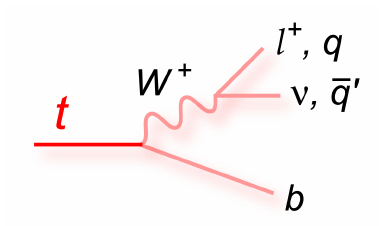
Figure 2. Candidate event for the ttH process, in which one W boson decays to two quarks producing 4 total jets